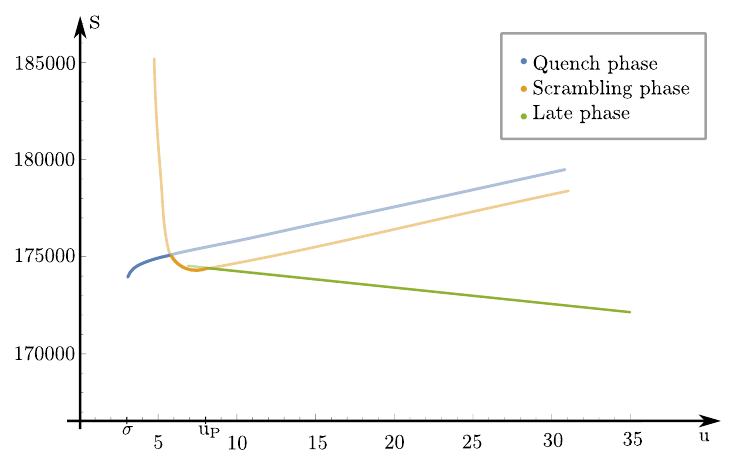
Figure 6. The generalized entropy of the three saddles of QM L +semi-infinite segment of radiation in the bath. The entanglement entropy is obtained by minimizing between the generalized entropy of these saddles. In this plot, this is reflected in the use of a transparent color whenever the saddle is not dominant. The value of the parameters used in this plot can be found in table